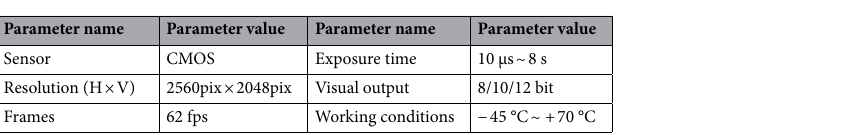
Table 1. Camera and hardware related parameters.